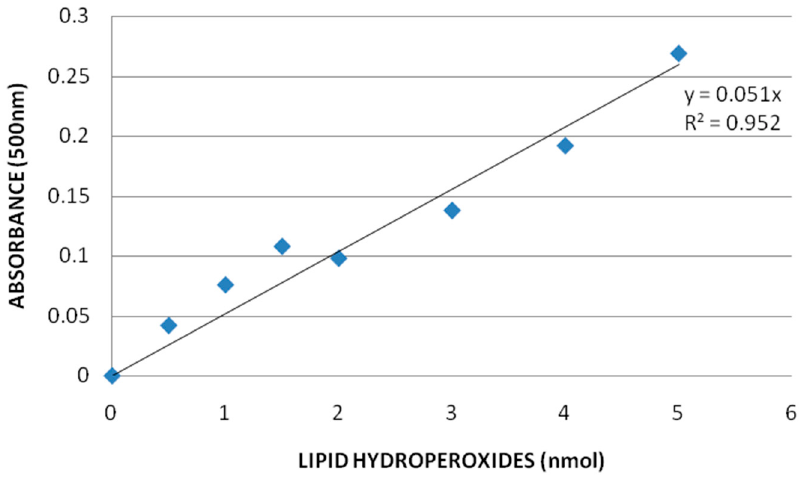
Figure 8. Standard curve for Lipid hydro peroxides (LPO) assay where y-axis represents absorbance at 500 nm whereas x-axis represents the concentrations of reference standard (nmol).